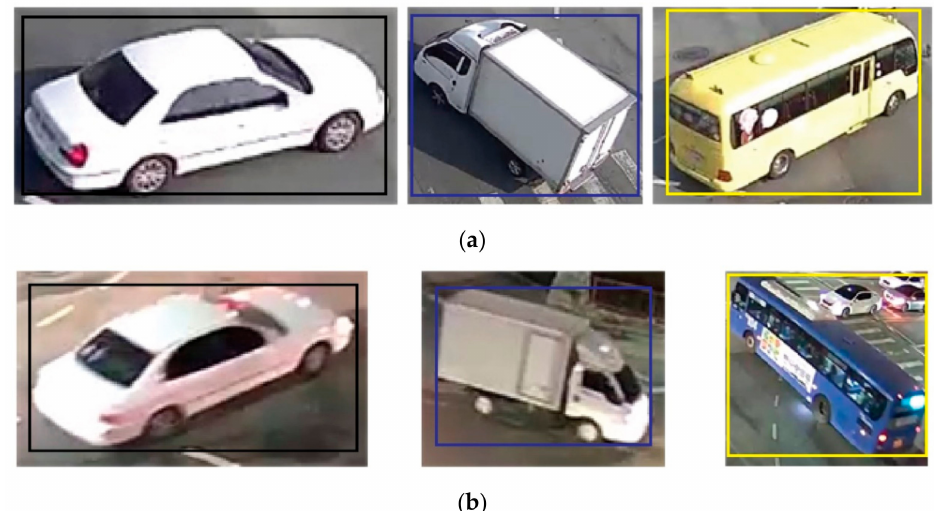
Figure 10. Example of the training dataset: (a) daytime images; ( b ) nighttime images.